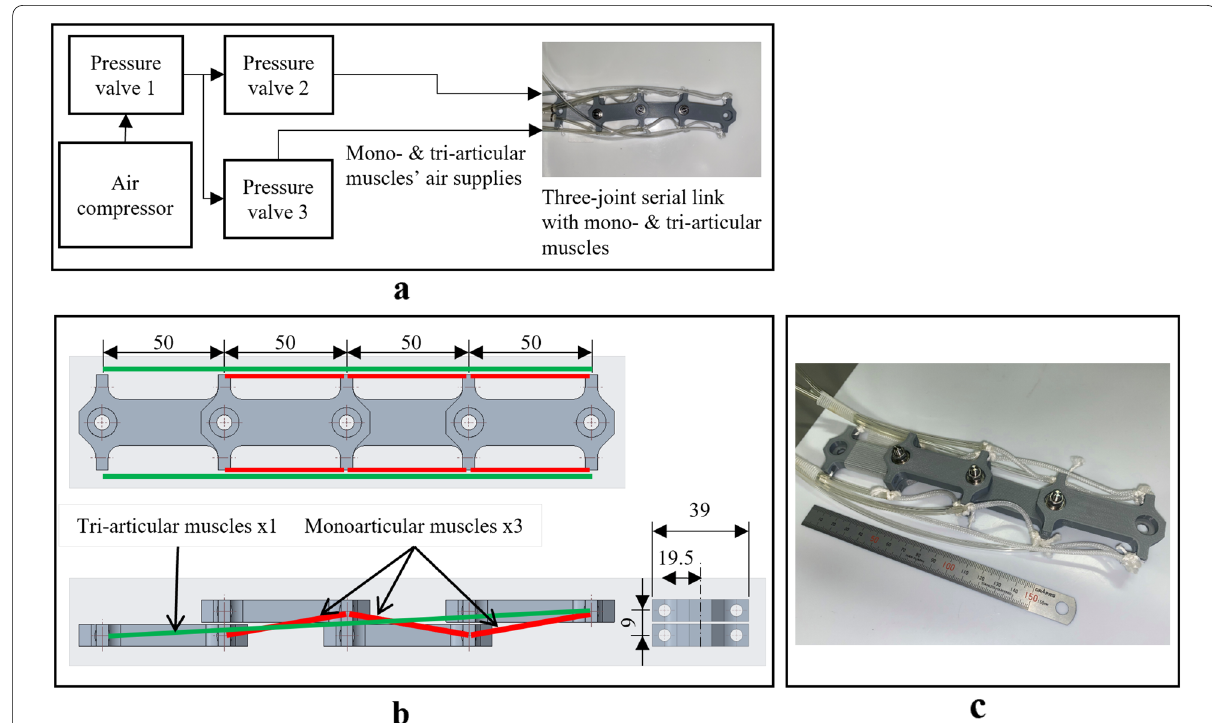
Fig. 6 a Diagram and photograph of experimental equipment, b diagram of multi-serial-link mechanism showing dimensions and attachment points of monoarticular and multiarticular muscles (unit: millimeters), and c experimental setup of the multi-serial-link mechanism driven by the McKibben artificial